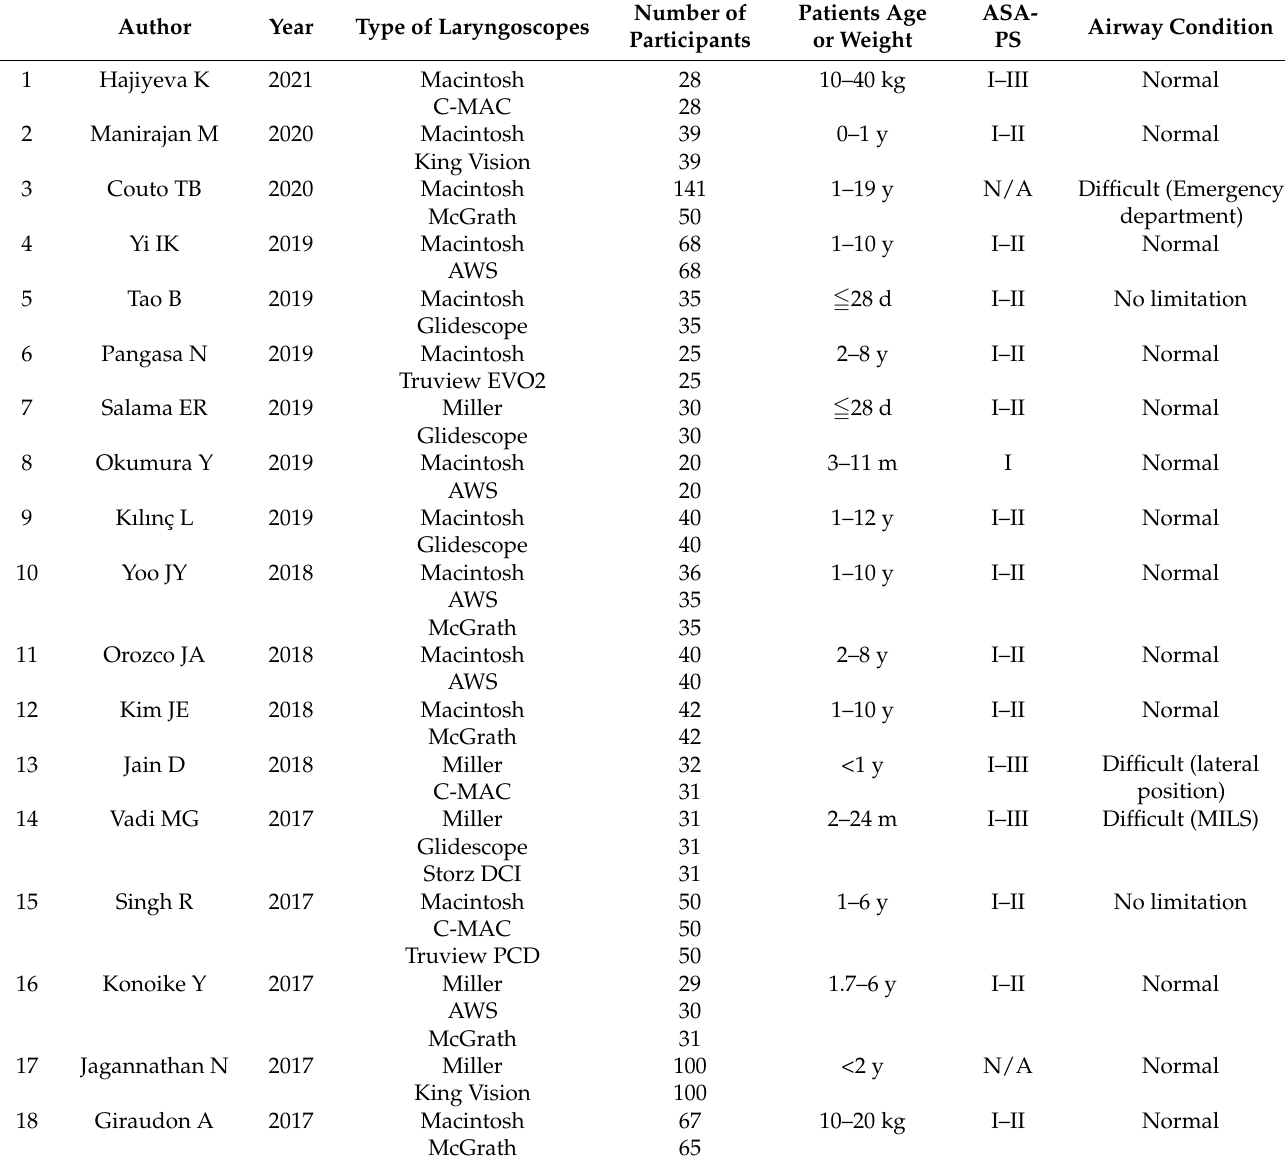
Table 1. Patients